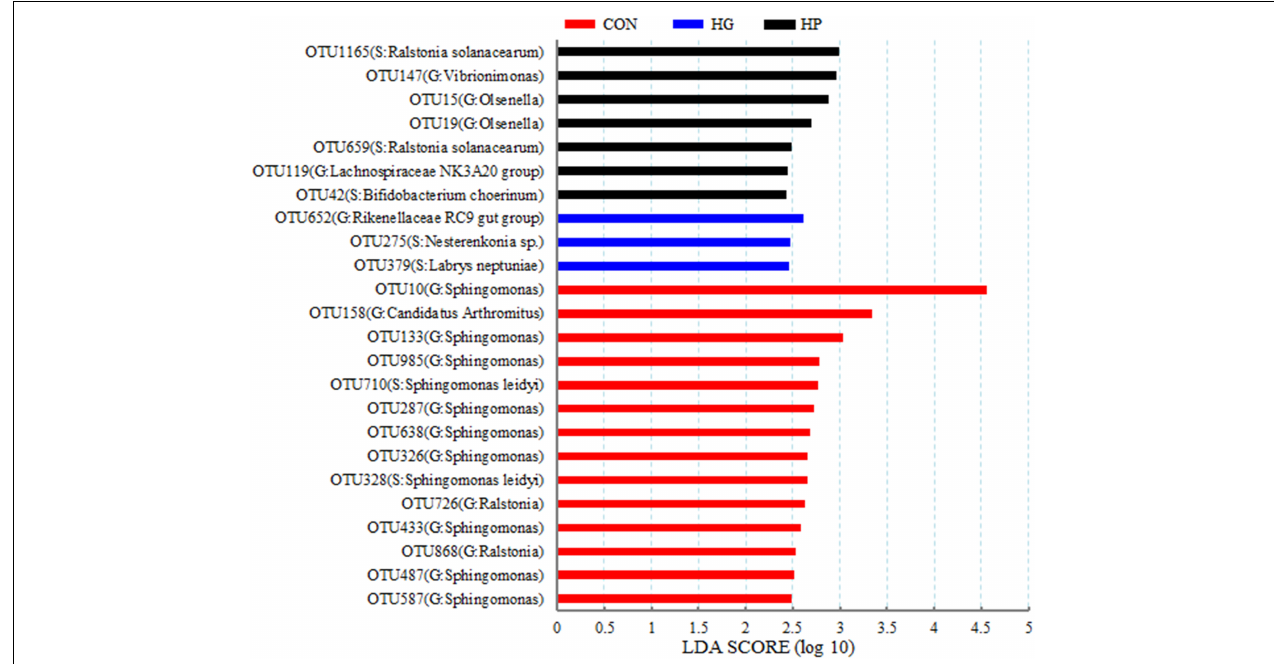
FIGURE 2 | Linear discriminant analysis (LDA) scores of the microbial OTUs in the ileal mucosa of Hu sheep fed CON, HG, and HP diets.